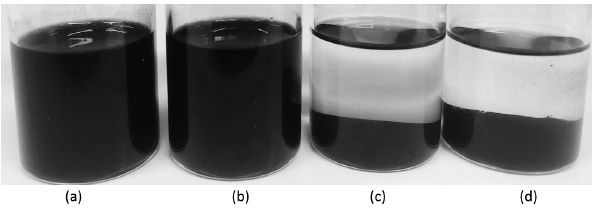
Figure 8. fMWCNT/solvent dispersion after 14 days: ( a ) Water; ( b ) Ethanol; ( c ) 2-propanol; ( d )